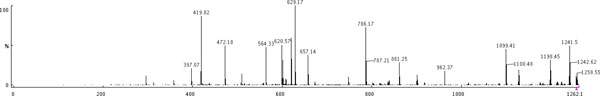
A real tandem mass spectrum.